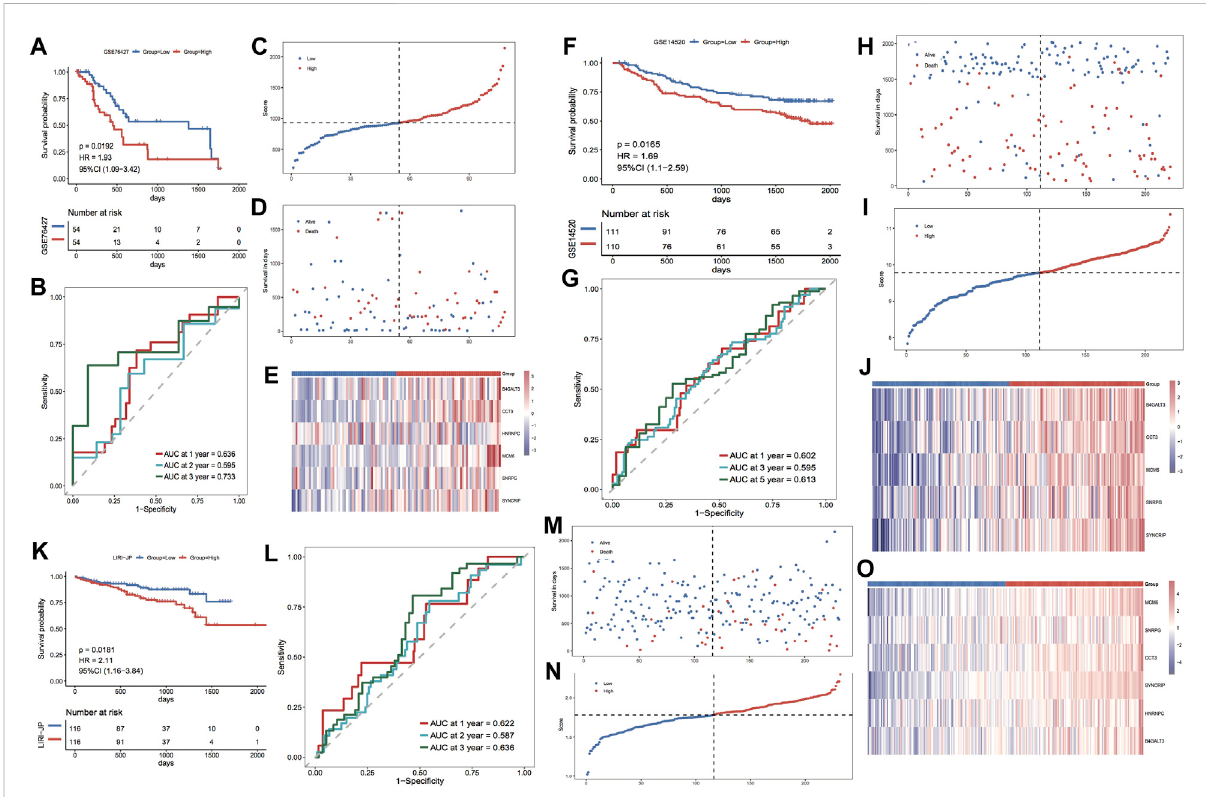
FIGURE 7 Prognosticef fi cacyofthevalidation modelfor theGEO dataset. (A,B) KMcurvesand ROC curves for validation setGSE76427; (C – E) Risktriple- plot for validation set GSE76427; (F,G) KM curves and ROC curves for validation set GSE14502; (H – J) risk triple-plot for the validation set GSE14502; (K, L) risk triple-plot for the validation set KM curves and ROC curves of LIRI-JP; (M – O) risk triple-plot diagrams of the validation set